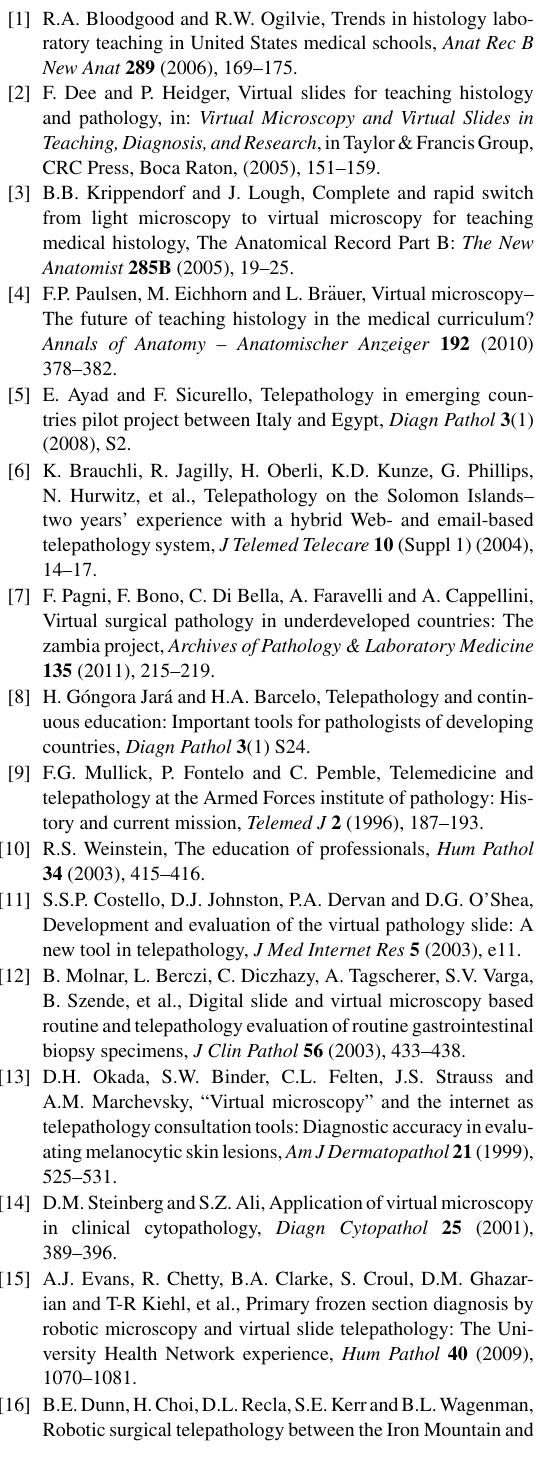
Figure 1. Photo courtesy of Dr. Kirk Patrick Uy. Figure 2. Photo courtesy of Dr. Siegfried Perez;